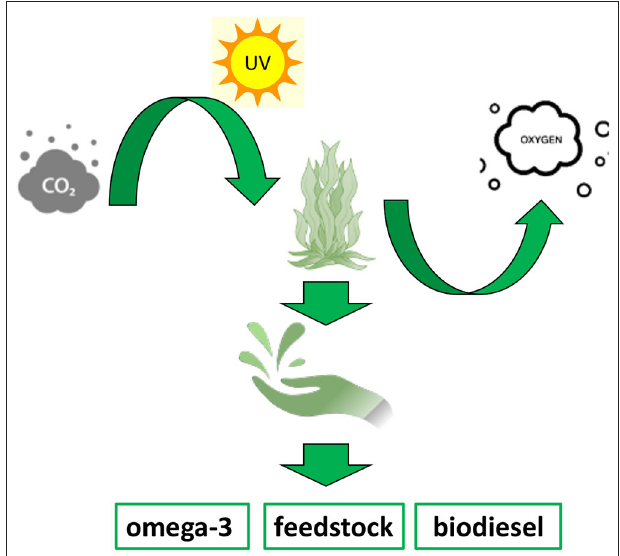
FIGURE 4 | The cartoon is a schematic representation of the algae aquaculture bioprocess and of different products that can be obtained by fatty acid-rich